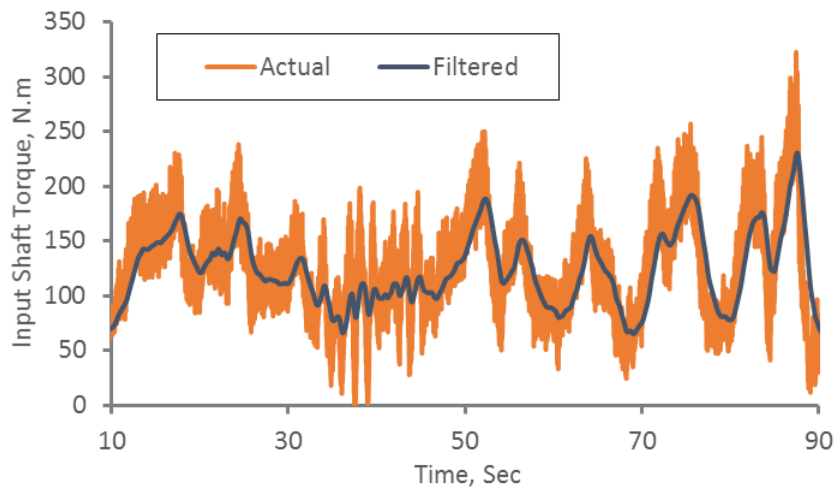
Figure 21. Measured and filtered input shaft torque during plowing operation using the control system.